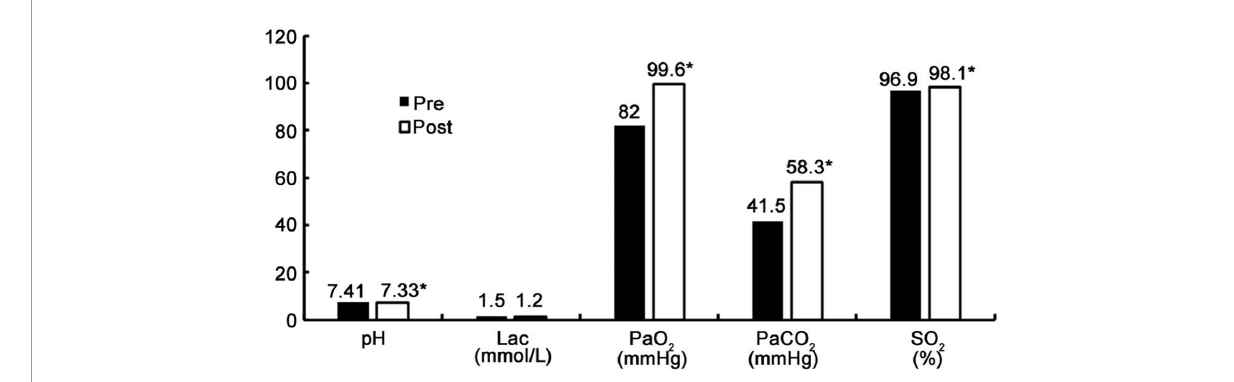
FIGURE3 Results of arterial blood gas analysis before and after procedure. * P < 0.05.